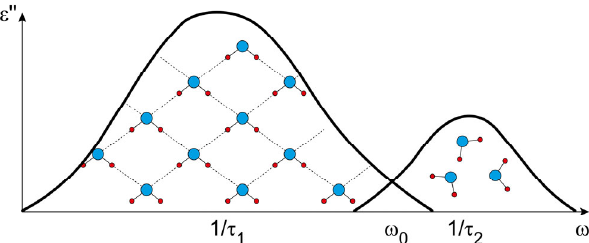
Figure 1. Schematic description of the location of orientation relaxation bands of bound and free water molecules. ω 0 is the selected frequency at which the process of orientational polarization of free water molecules is considered.